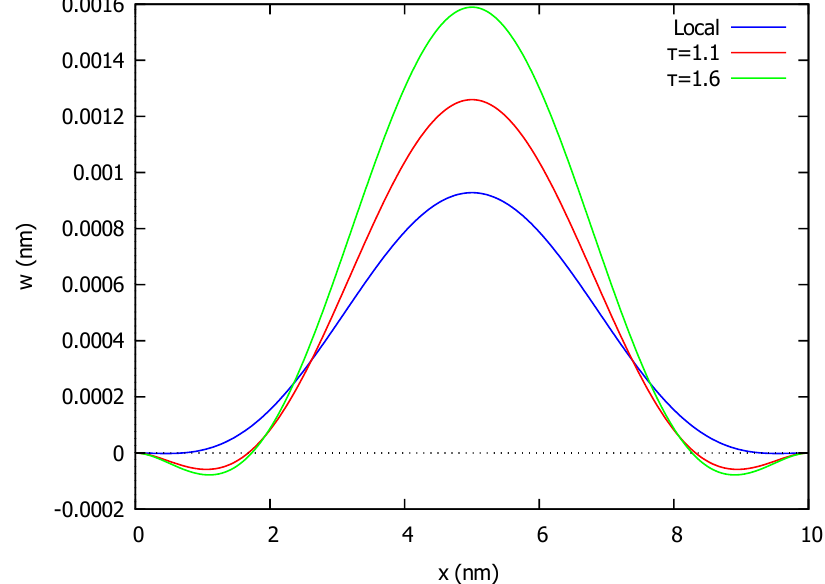
Figure 9. Deflection of clamped beam (CP) under variable load and different values of τ